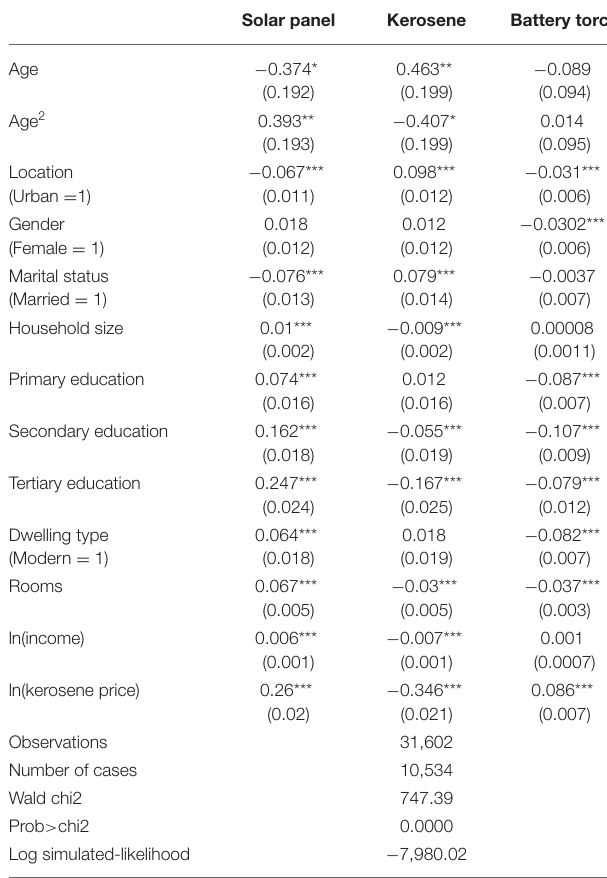
TABLE 5 | Average marginal effects of the multinomial probit model. Solar panel Kerosene